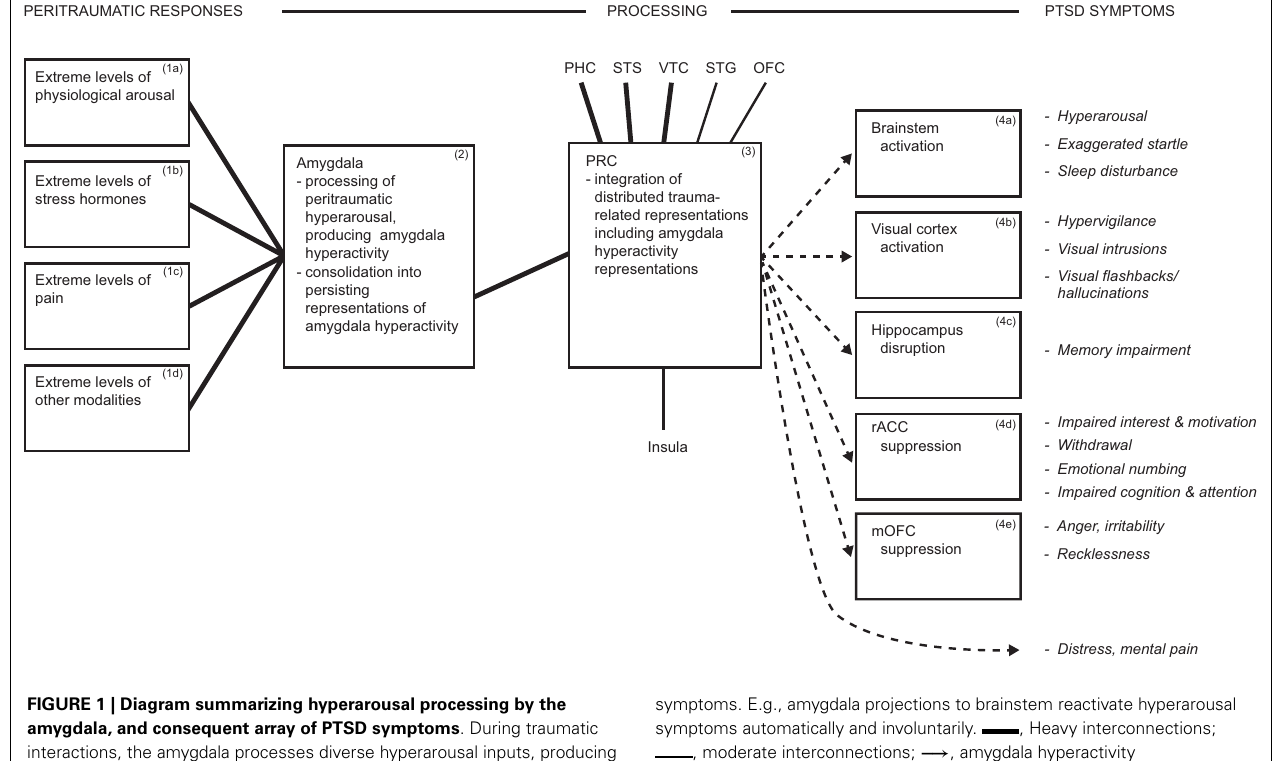
FIGURE 1 | Diagram summarizing hyperarousal processing by the amygdala, and consequent array of PTSD symptoms . During traumatic interactions, the amygdala processes diverse hyperarousal inputs, producing amygdala hyperactivity. Consolidation in the amygdala generates persisting representations of hyperactivity, which participate in distributed trauma-related representations. Reminders reactivate the distributed trauma-related representations, including those mediated by the amygdala, which influence further brain regions and thereby drive multiple PTSD